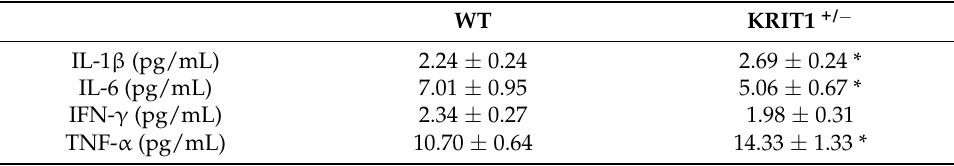
Table 2. Plasma levels of inflammatory cytokines. Concentrations of interleuchin-1 β (IL-1 β ), interleuchin-6 (IL-6), interferon- γ (IFN- γ ), and tumor necrosis factor- α (TNF- α ) evaluated in plasma of wild-type (WT) and heterozygous KRIT1 knockout (KRIT1 +/ − ) mice by Bioplex immunoassay (BioRad). Data are means ± SEM of 7 mice per group. * p < 0.05 vs.